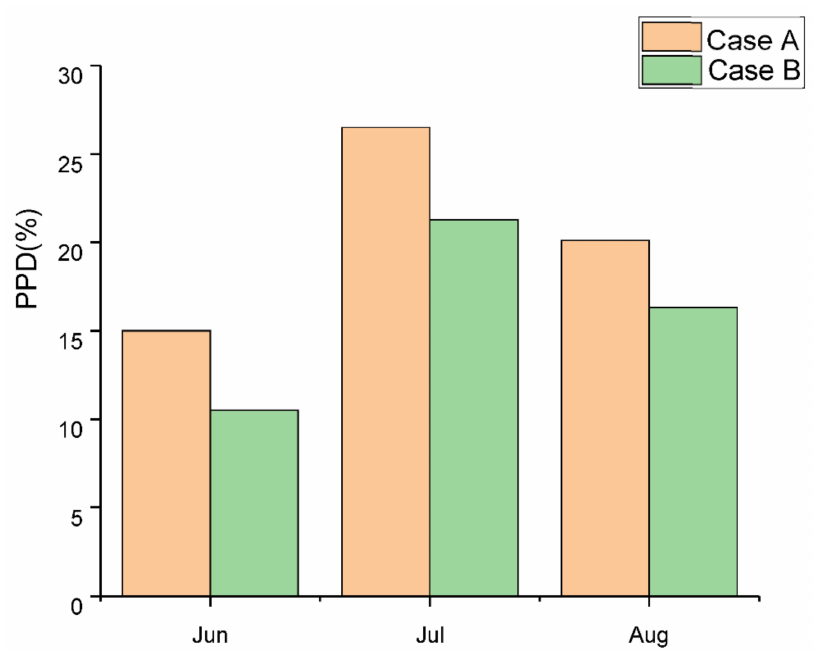
Figure 24. Comparison of the average PPD in June, July and August for zone 44 in case A (no low-E film) and case B (with low-E